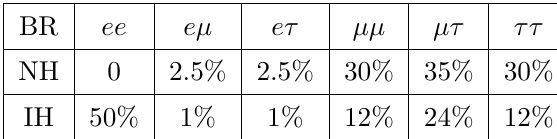
Figure 1 . Scatter plots for the H ++ decay branching fractions to the (cid:13)avor-diagonal (a, b) and (cid:13)avor-o(cid:11)-diagonal (c, d) like-sign dileptons versus the lowest neutrino mass for NH (a, c) and IH (b, d) with (cid:8) 1 = (cid:8) 2 = 0.